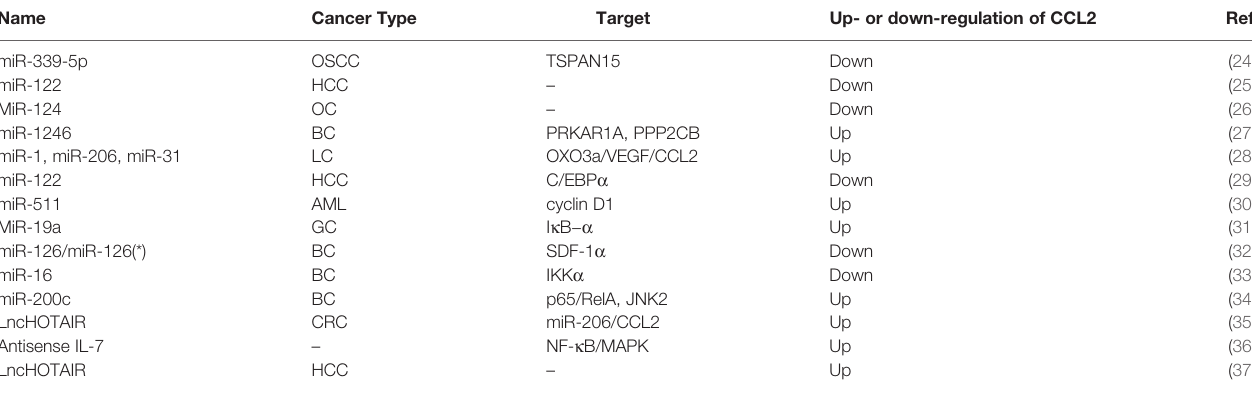
TABLE 1 | Non-coding RNAs and mechanisms involved in CCL2 regulation.